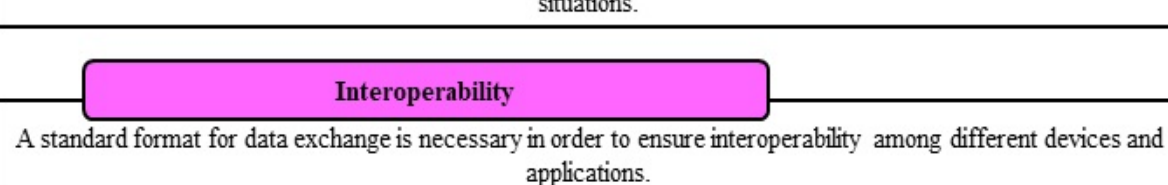
Figure 2. Major Technological Challenges of